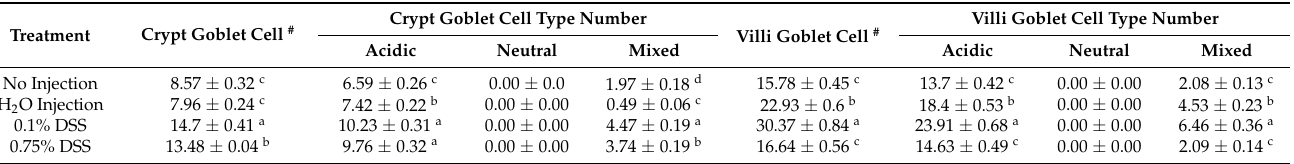
Table 6. Effects on intestinal villi and crypt goblet cells of the duodenum after the intra-amniotic administration of experimental